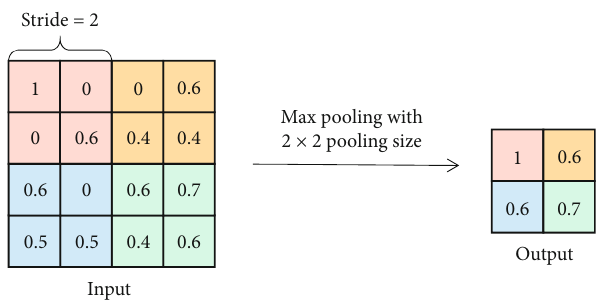
Figure 4: The illustration of the max pooling